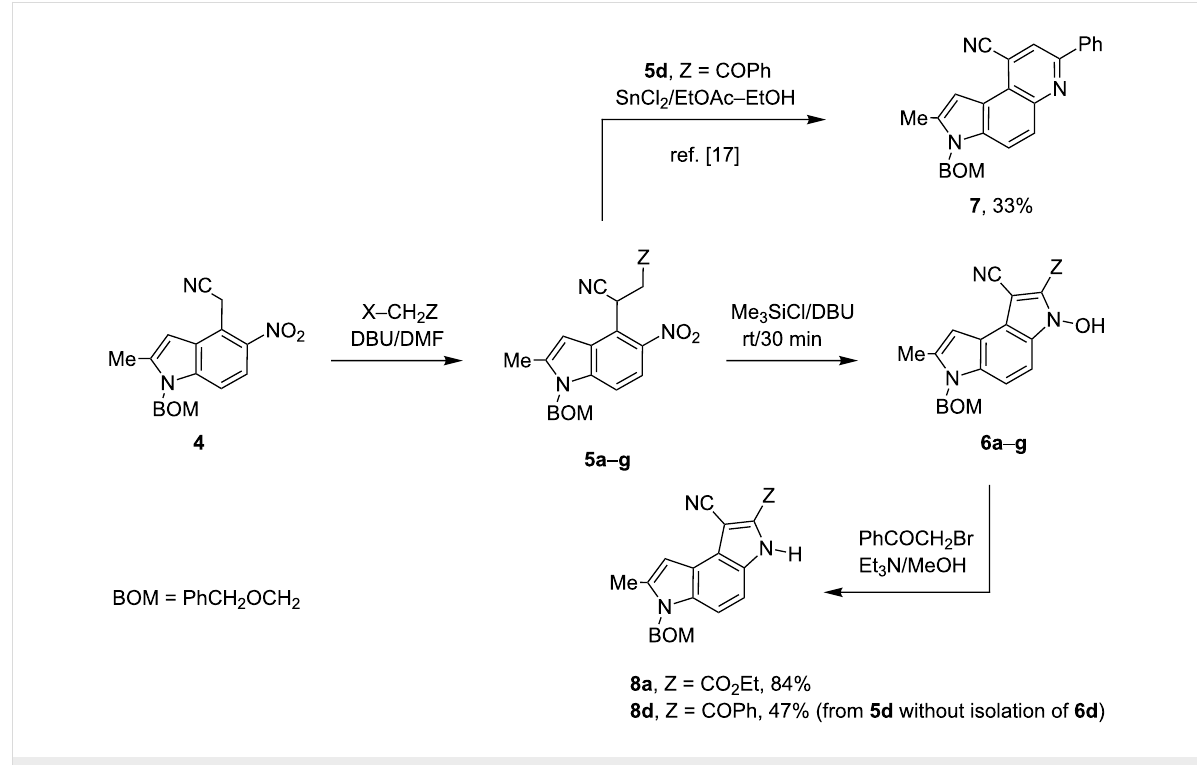
Scheme 2: Synthesis of pyrrolo[3,2- e ]indoles 6